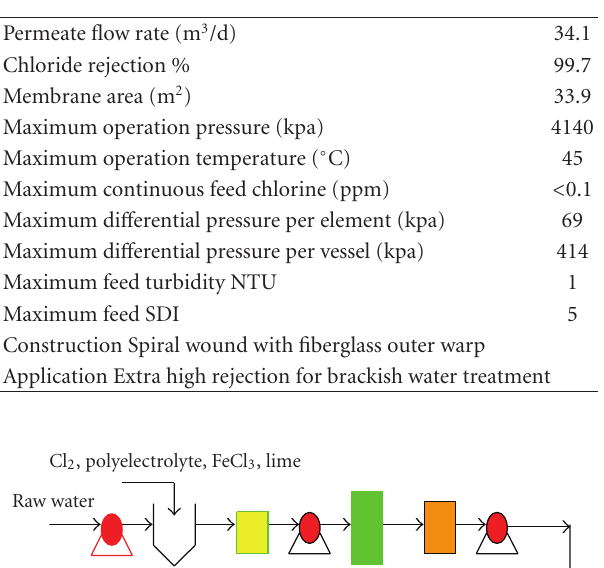
Table 1: General properties of Koch membrane type TFC-8822XR- 365ft 2 .